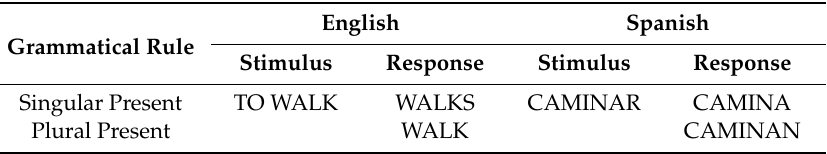
Table 2. Sample stimuli for Spanish and English trials.